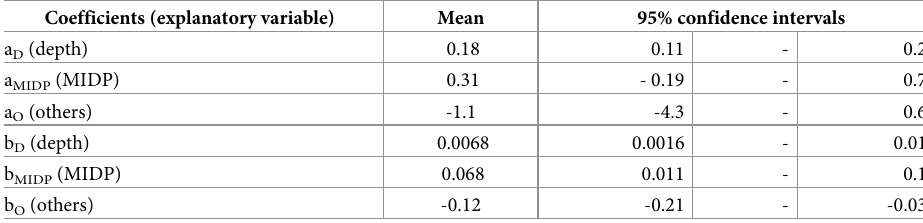
Table 3. 95% CI for each parameter based on prior distributions computed by MCMC